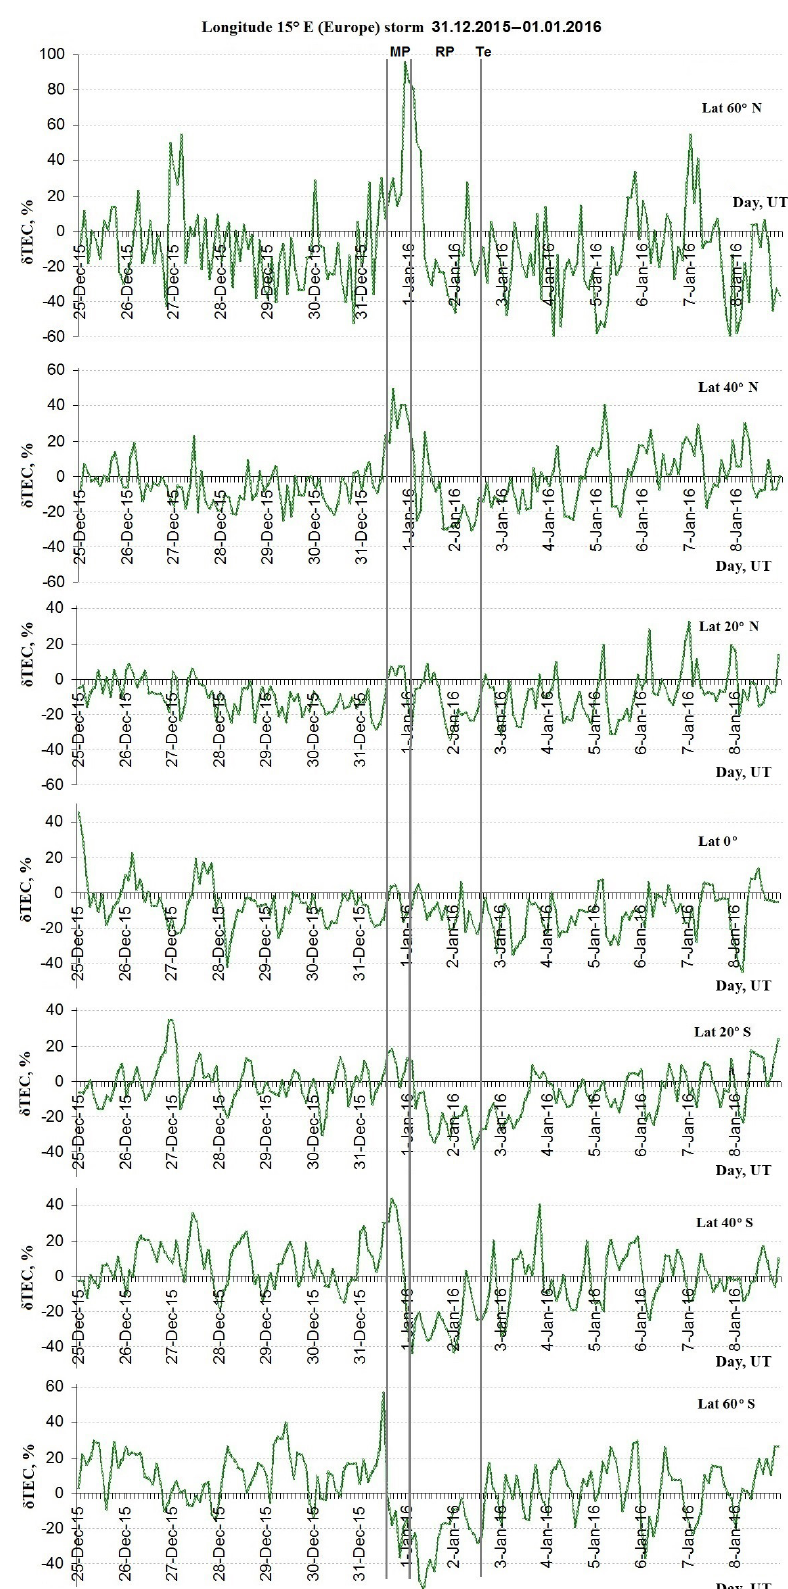
Figure 2. Weak manifestation of TEC effects within the latitudes ± 20 ◦ during the storm of 31 December 2015. MP, RP and Te are marked by vertical